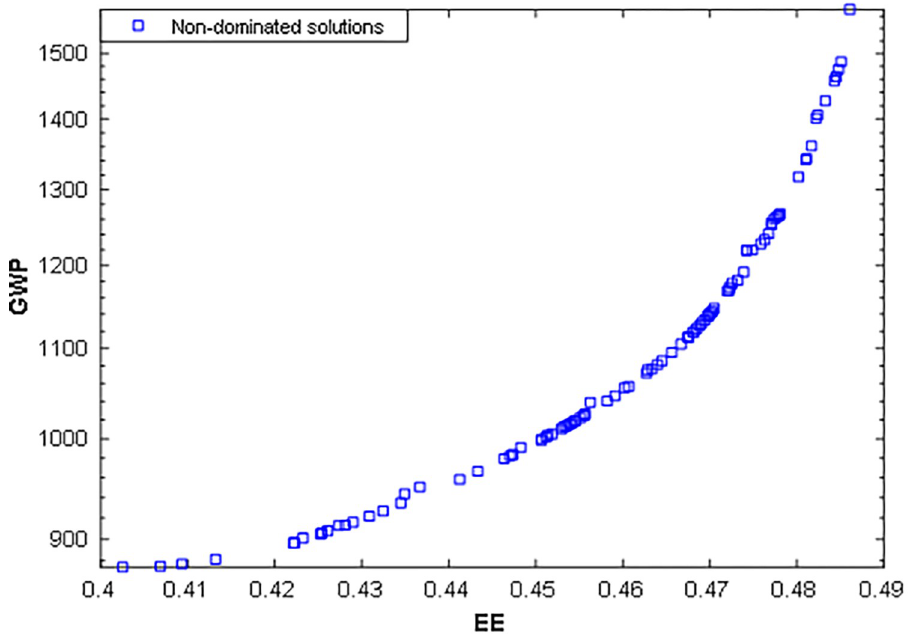
Fig 9. Pareto optimal solutions of the third scenario using